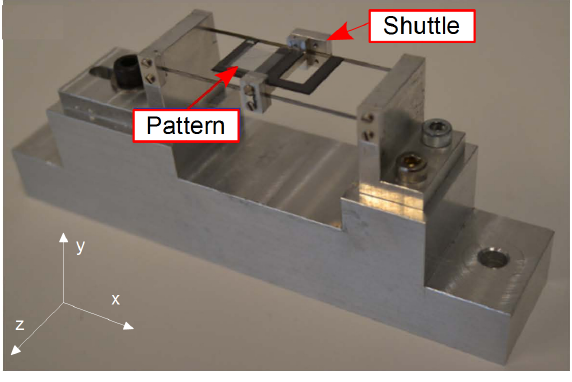
Figure 12. Shuttle used as target in real-time experiments.